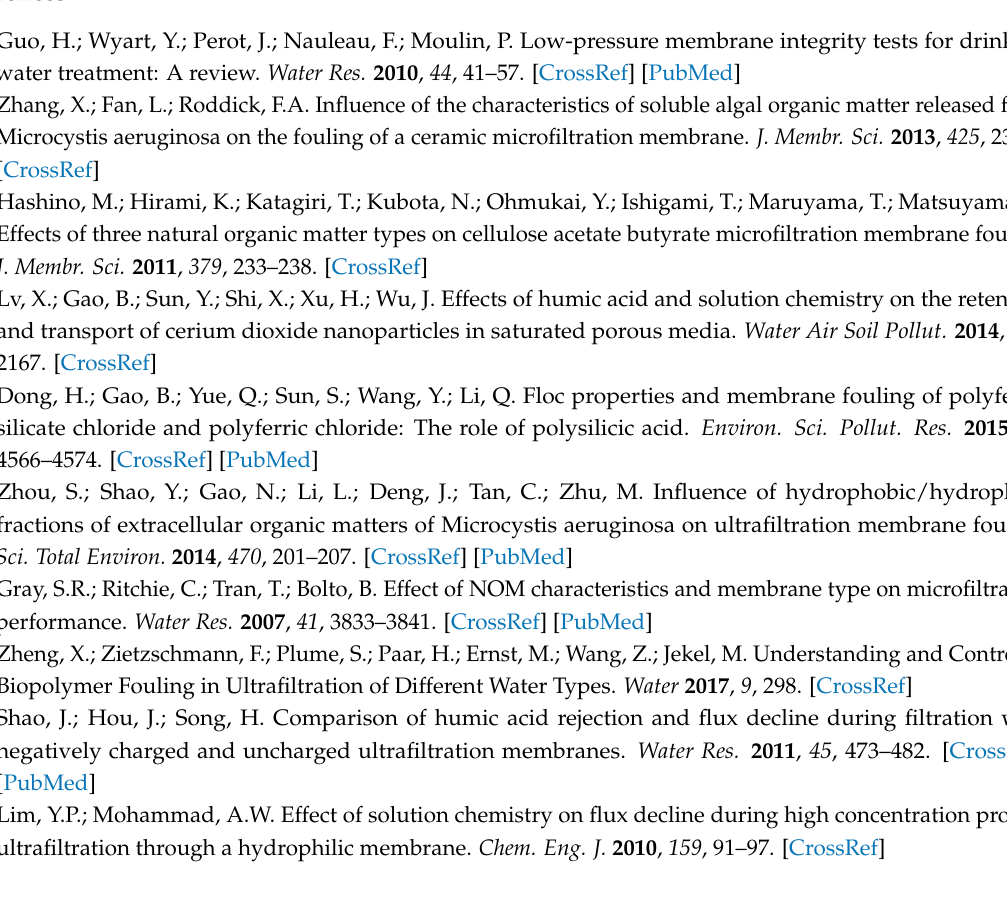
Figure S2: SEM characterization results at different solution conditions: (a) pH = 7.0, IS = 10 mM, c (Ca 2+ ) = 0 mM; (b) pH = 3.0, IS = 10 mM, c (Ca 2+ ) = 0 mM; (c) pH = 7.0, IS = 100 mM, c (Ca 2+ ) = 0 mM; (d) pH = 7.0, IS = 10 mM, c (Ca 2+ ) = 1.0